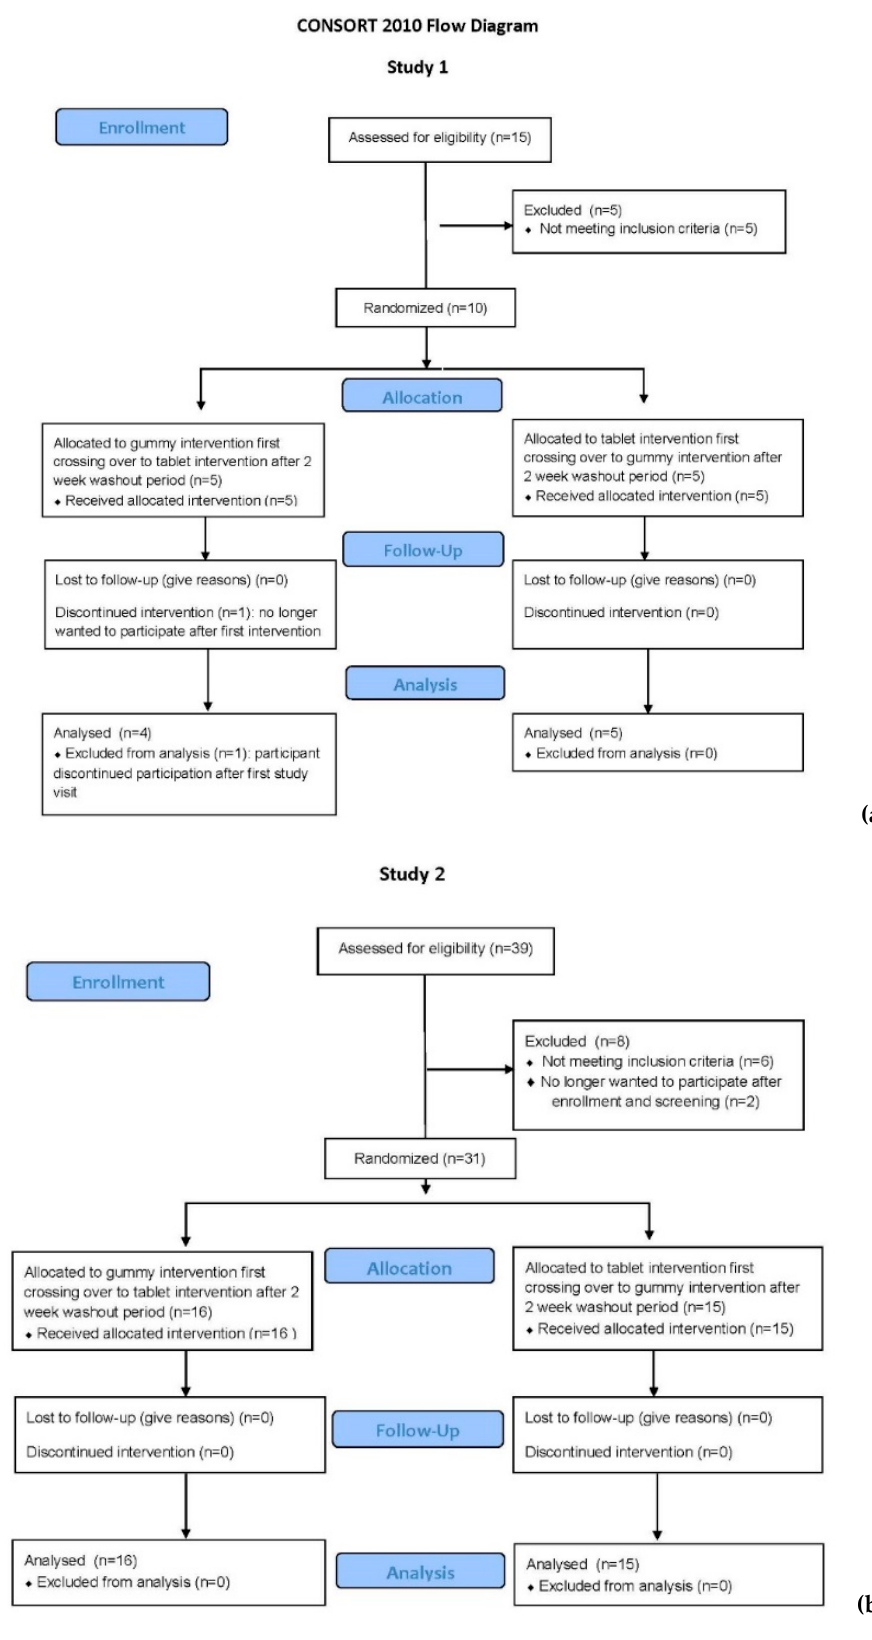
Figure 1. CONSORT flow diagrams of Studies 1 and 2.